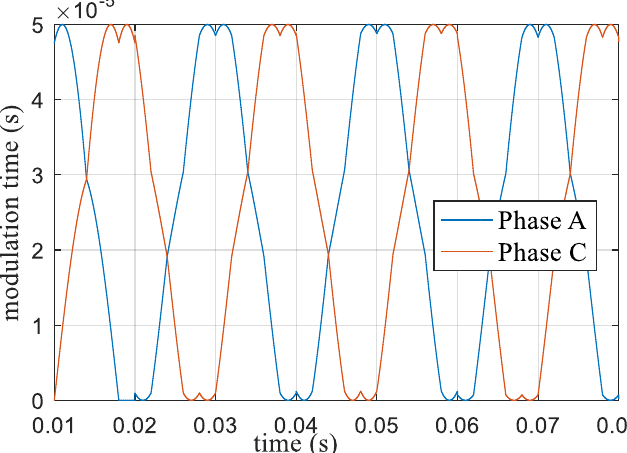
Figure 12. Harmonic characteristics at m = 1.0514.